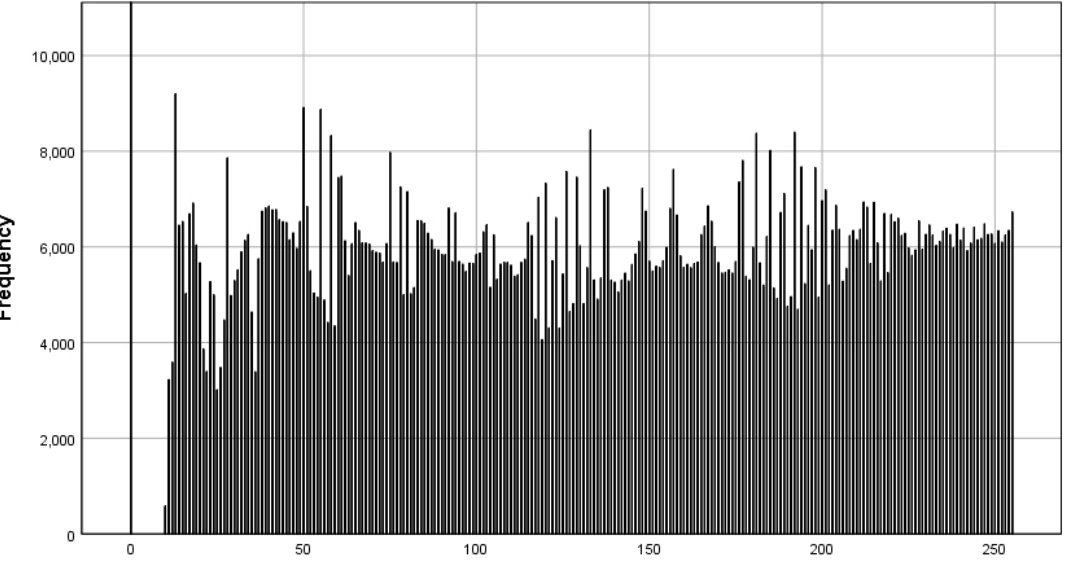
Figure 3. The flattened histogram of the resulting rescaled image from the RS algorithm application (linear scale, class 0: omitted due to no data value; SW/left bottom corner/part of testing scene).